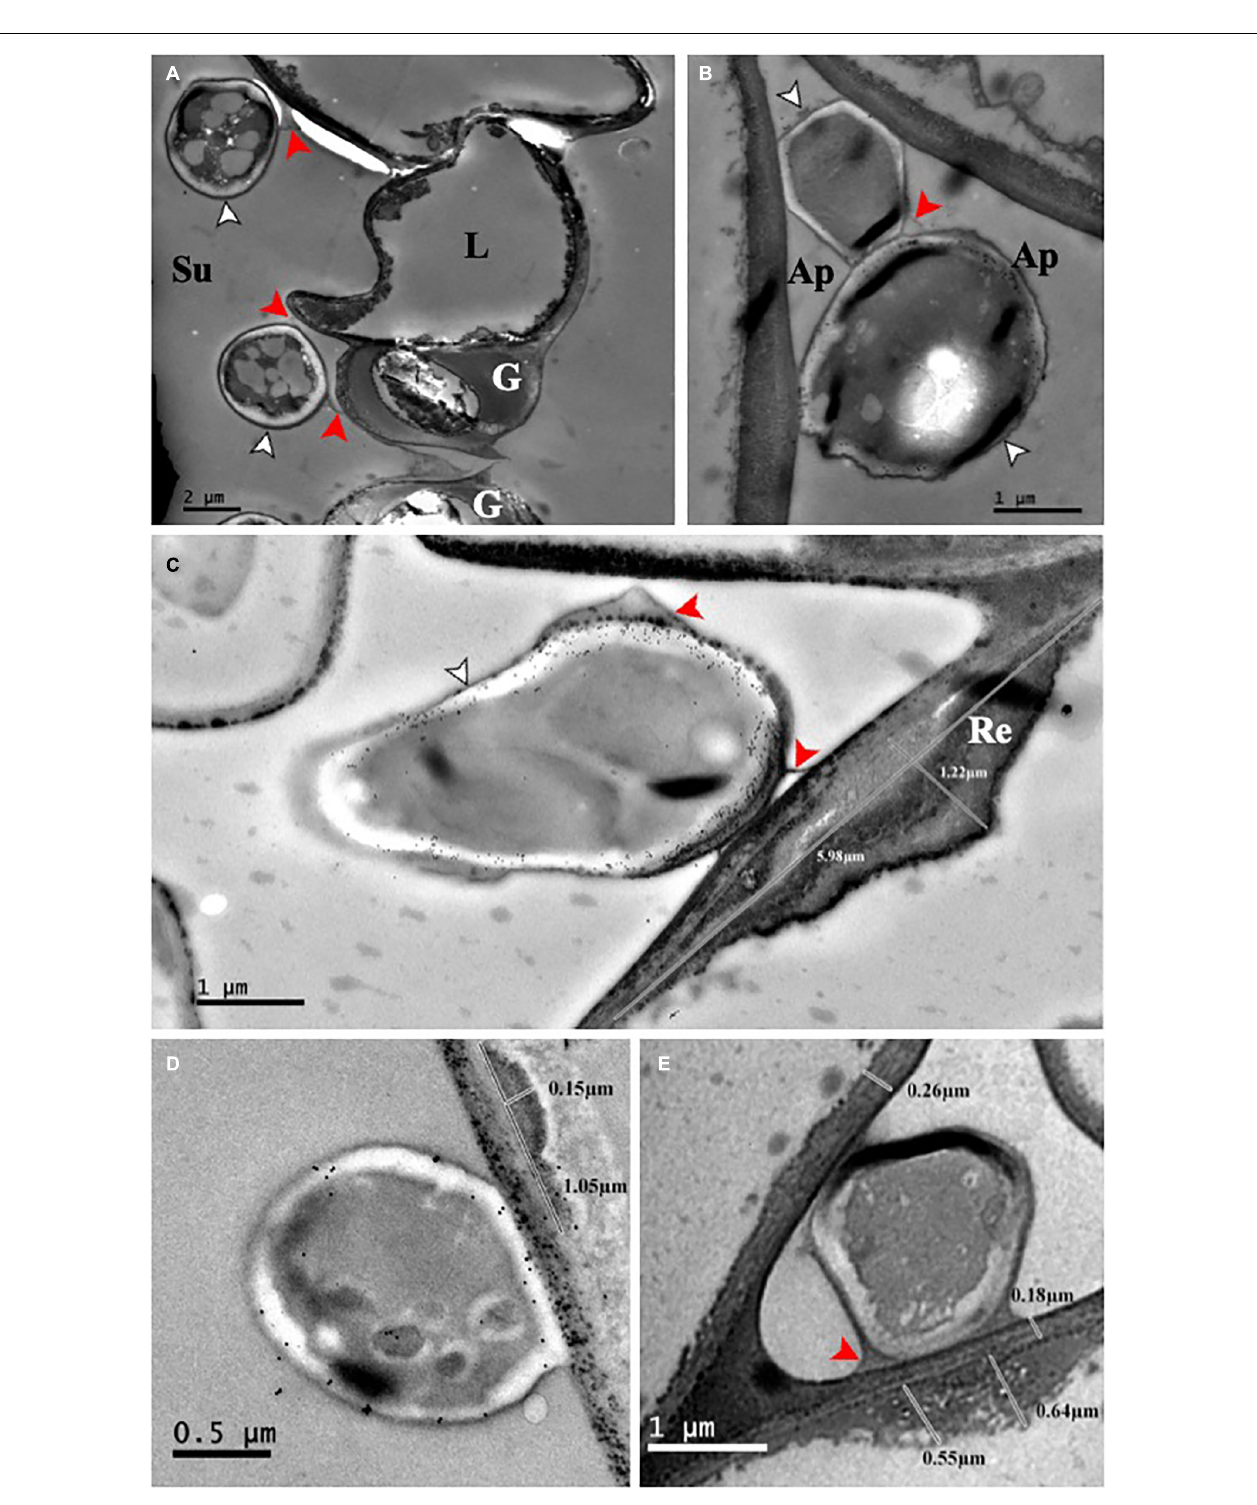
FIGURE 2 | Ramularia collo-cygni – barley (cv Fairytale) adherence and plant response. (A) NZ11-GFP, 21 dpi. In the substomatal cavity, the hyphae adhere to the epidermal and guard cells through an ECM. (B) DK05-GFP, 27 dpi. Infecting hyphae growing intercellularly directly adhere to the cell wall. (C) DK05-GFP 21 dpi. The ECM protrudes from the fungus toward the plant cell wall. At the site of contact between the fungus and the host cell, a plant cell wall reinforcement is visible. (D) DK05-GFP 27 dpi WGA colloidal gold labeled. (E) DK05-GFP 21 dpi unlabeled. Ap, apoplast; G, guard cell; L, lateral cell; Re, cell wall reinforcement; Su, substomatal cavity; Hyphae, white arrowhead; ECM, red arrowheads.